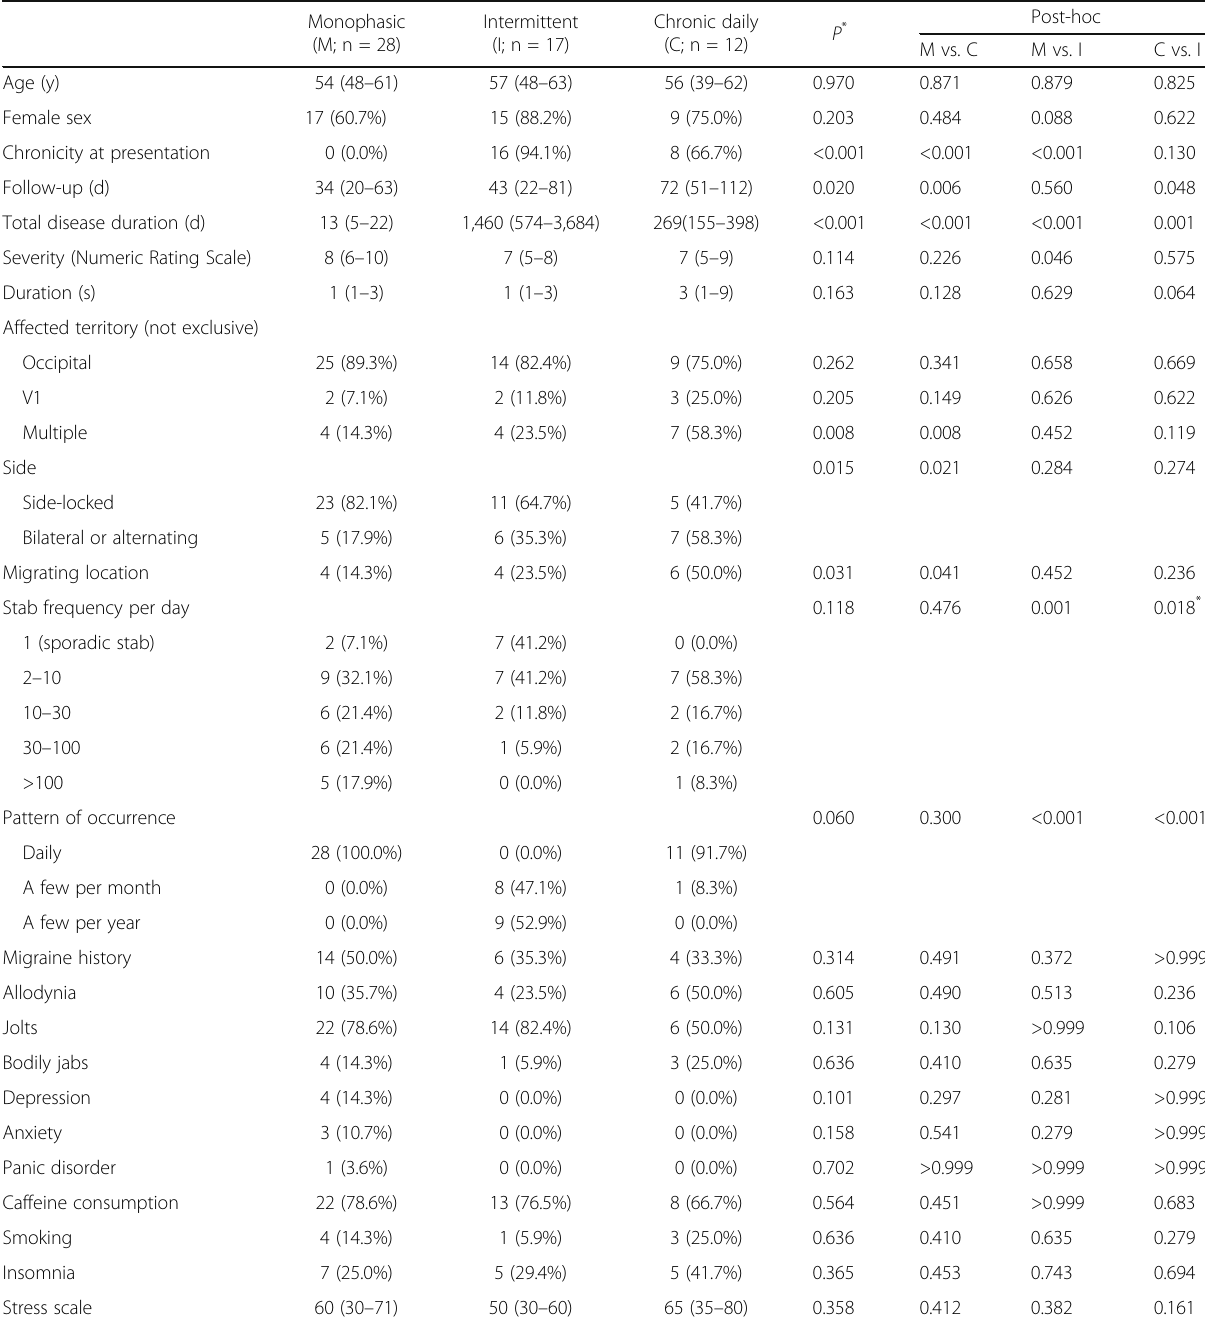
Table 3 Patient characteristics for different clinical